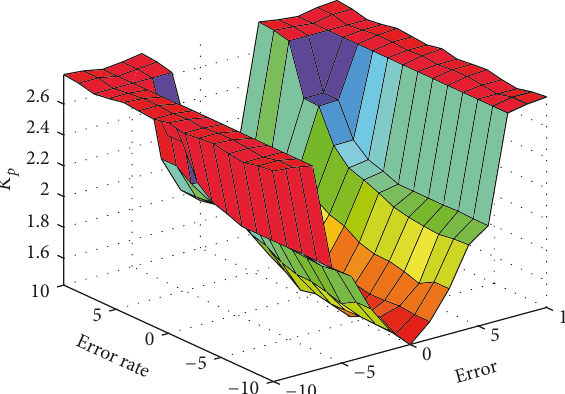
Figure 11: Error and derivative error for the output 𝑘 𝑝